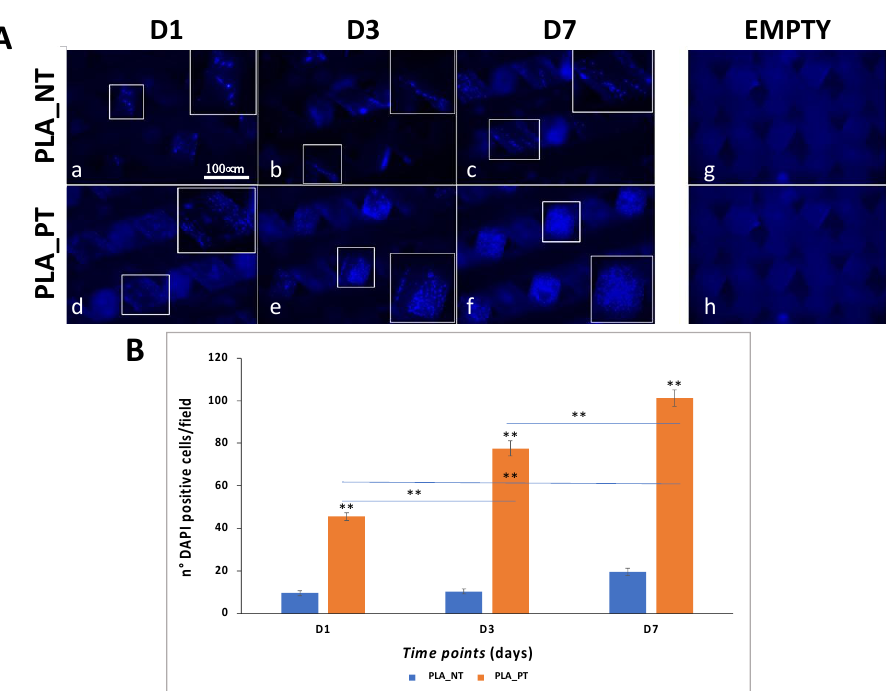
Figure 6. Cell proliferation analysis of hFOB cells cultured on PLA_NT and PLA_PT scaffolds for 1, 3 and 7 days (D1, D3 and D7) by DAPI staining. ( A ) Representative DAPI images of: hFOB cells cultured on PLA_NT ( a – c ) and PLA_PT ( d – f ) scaffolds, empty scaffolds PLA_NT ( g ), and PLA_PT ( h ). Scale bar 100 mm. ( B ) Graphical representation of the number of DAPI positive cells/field. Data are reported as mean ± standard deviation obtained on 3 scaffolds. ** p < 0.01 indicates significant differences between the different time points and scaffolds, as reported by the Holm post-hoc test.